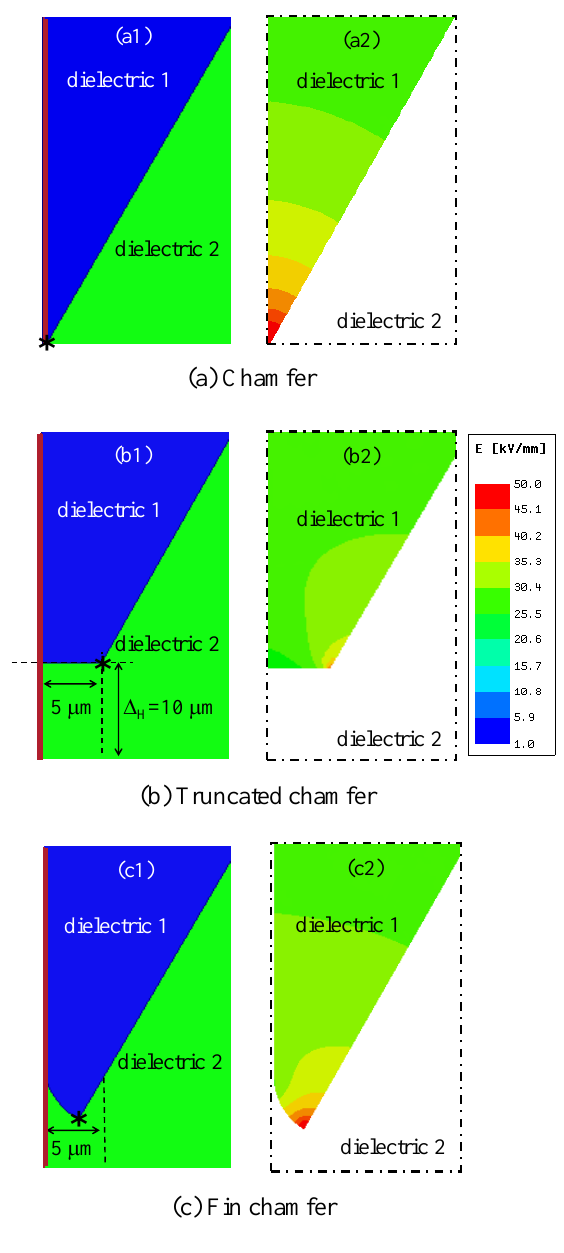
Figure 9: (a) Chamfer, (b) Truncated-chamfer, and (c) Fin-chamfer singularity shapes; the chamfer is a triple- point singularity, while the truncated-chamfer and the fin- chamfer are dielectric-dielectric corners. Figs.(a1), (b1), and (c1) show the geometrical shapes, where the asterisks (*) indicate, as usual, the singularity points. As shown in Figure (b1), the truncated-chamfer shape feature a “trunca- tion height” ∆ H = 10 µ m. In the application of the proposed method, the control volume is centered at the respective (*) for each shape. Figs. (a2), (b2), and (c2) display E in “di- electric 1”. The colormap legend ranges from 1 kV/mm to 50